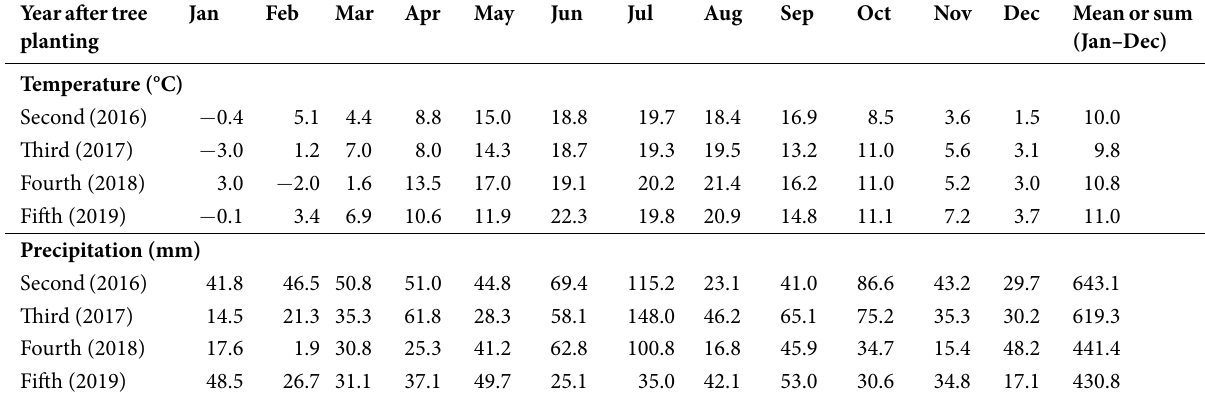
Table 1 Total precipitation and mean temperatures at the Wrocław-Strachowice Station (51°06 ′ 14 ″ N, 16°52 ′ 55 ″ E) in the years 2016 to